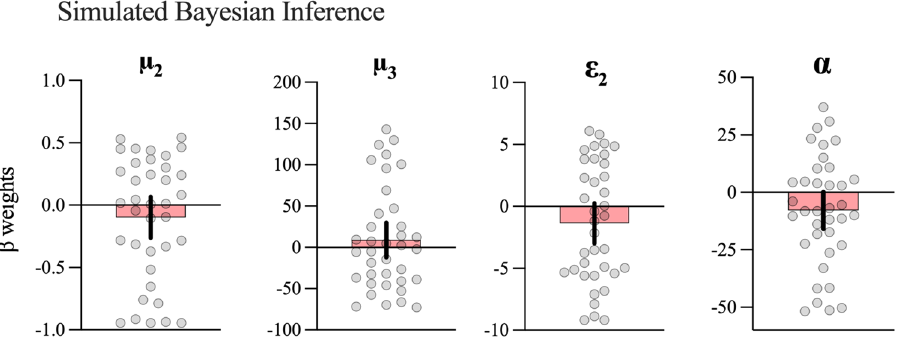
Figure 7. β weights for simulated Bayesian inference. Means and 95%CIs for beta weights for each parameter from the simulated Bayes optimal observer model